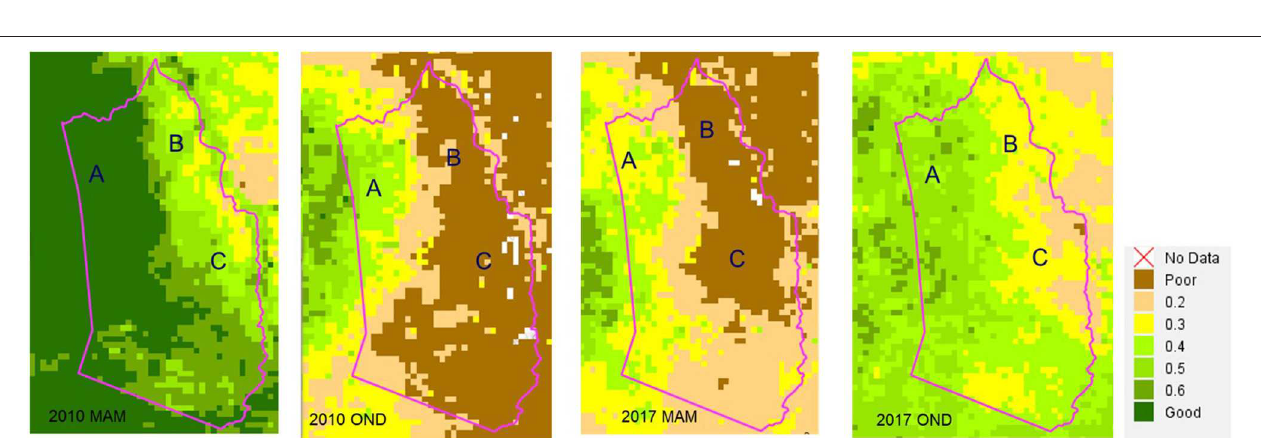
FIGURE 8 | Seasonal VCI for IlNgwesi on two drought years during the long rains (MAM) and Short rains (OND) seasons.